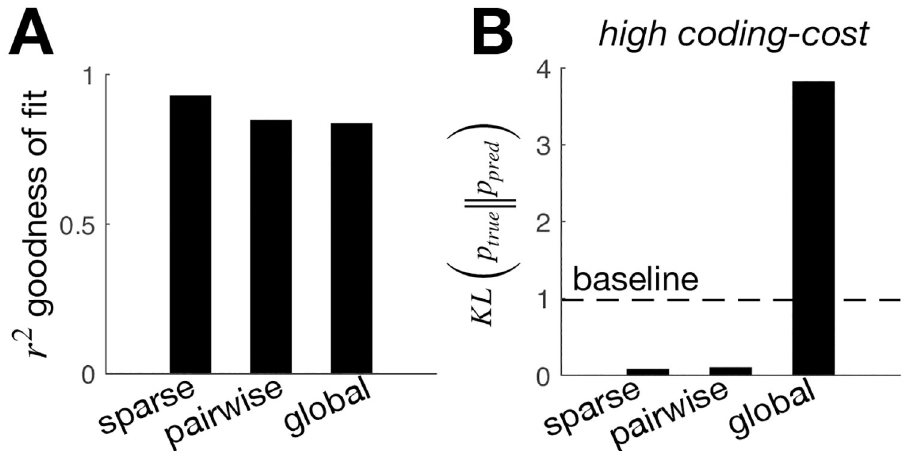
Fig 6. Effect of assuming different types of reward function. We compared the inferred reward when we assumed a sparse model (i.e. a small number of states associated with non-zero positive reward) a pairwise model (i.e. the reward depends on the first and second-order response statistics) and a global model (i.e. the reward depends on the total number of active neurons only). ( A ) r 2 goodness of fit between the true and the inferred reward, assuming a sparse, pairwise, or global model. ( B ) The KL-divergence between the optimal response distribution with high coding cost (see Fig 5B) and the response distribution predicted using the reward inferred in the initial condition, assuming a sparse, pairwise, or global model. A horizontal dashed line indicates the KL-divergence between the response distribution with high coding cost and the original condition (that was used to infer the reward).